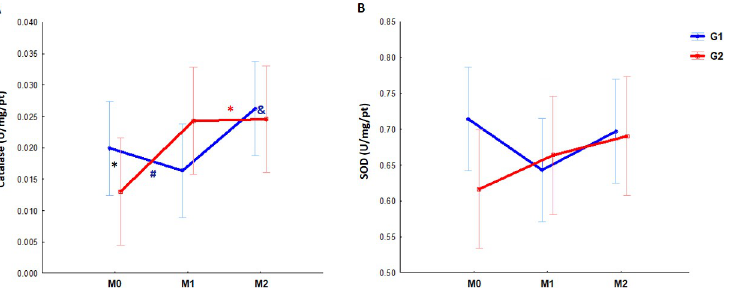
Fig 1. Longitudinal evaluation of antioxidant enzyme activity (superoxide dismutase [SOD] and catalase [CAT]) from 23 pregnant women infected and not infected by HIV. Bars: 95% confidence interval. M0: moment zero (first or second trimesters), M1: moment one (third trimester), M2: moment two (post-partum). G1 (red): HIV-positive women, G2 (blue): HIV-negative women. A ; � red: difference between M1 and M2 (p = 0.03), # blue: difference between M0 and M1 (p = 0.0004); & blue: difference between M0 and M2 (p = 0.001). � black difference between G1 and G2: M0 p = 0.05. Statistical analysis: